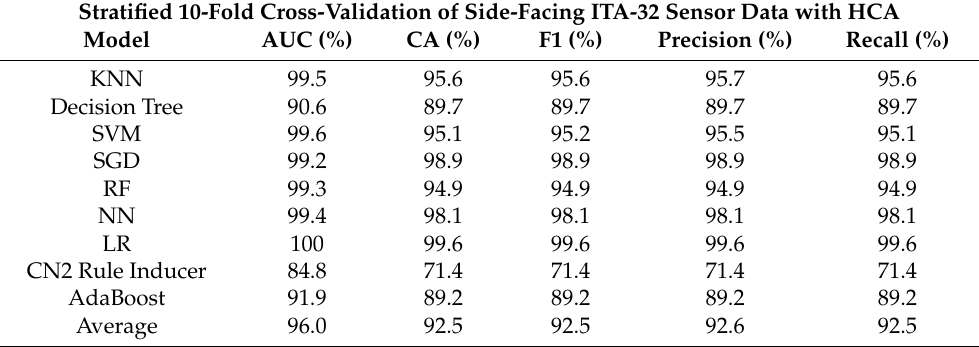
Table 3. Evaluation results showing the accuracies of data mining models during Classification-by- Clustering of a set of sprained ankle rehabilitation exercises data using the Hierarchical Clustering Algorithm